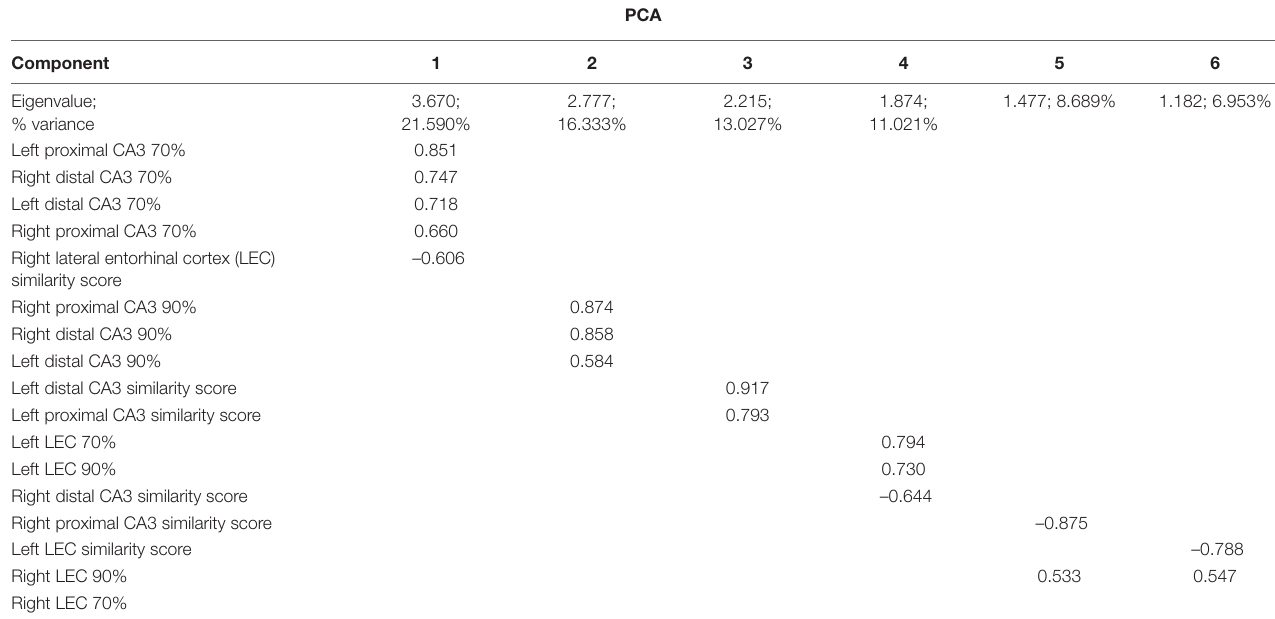
TABLE 1 | Rotated component matrix with varimax rotation from principal component analysis (PCA).